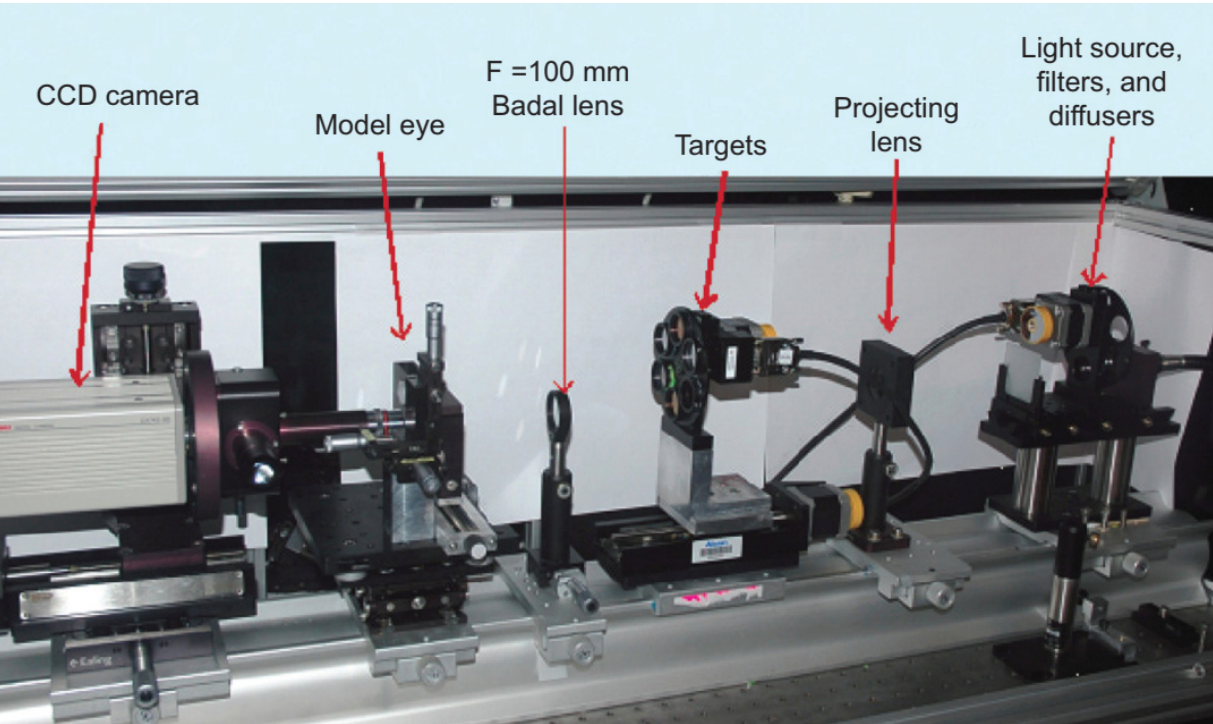
Figure 3. Typical setup of the ISO 11979–2 optical bench setup to evaluate the optical quality of IOLs, using a wet-cell eye model, and a Badal optometer (optional). Clinical Ophthalmology 2014:8 2105-2113 ([50]). Originally published by and reprinted with permission from Dove Medical Press Ltd.